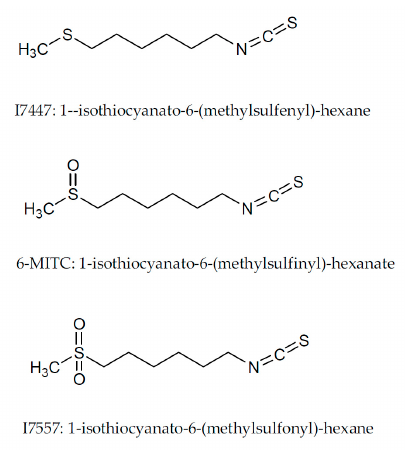
Figure 1. Chemical structures of 6-MITC and its derivatives, I7447 and I7557.